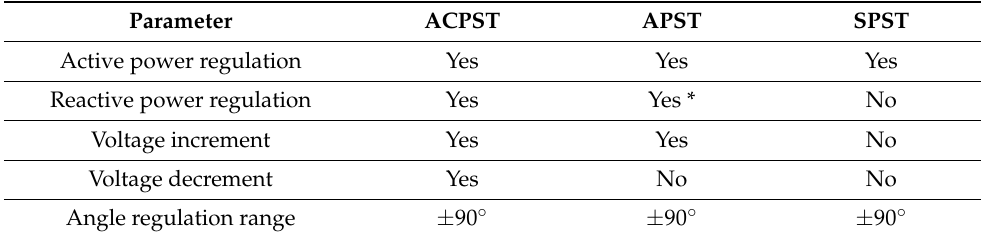
Table 4. The comparison of the considered PST. Parameter ACPST APST SPST Active power regulation Yes Yes Yes Reactive power regulation Yes Yes * No Voltage increment Yes Yes No Voltage decrement Yes No No Angle regulation